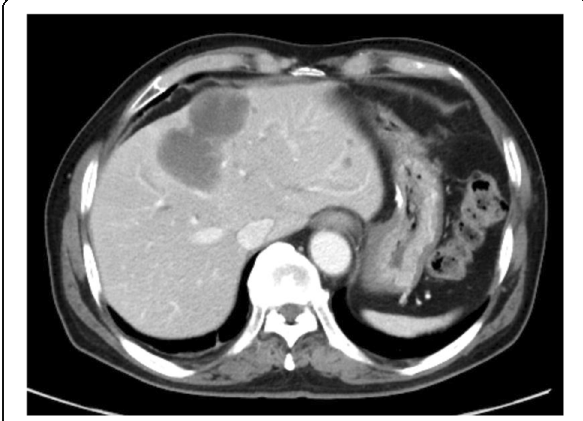
Fig. 2 Enhanced computed tomography findings. A 40-mm- diameter tumor in hepatic segments 3 and 4 (S3+4) with enhanced solid nodule along the wall was detected. On the right side of the tumor, there was a 50-mm tumor, which suggested hemorrhagic